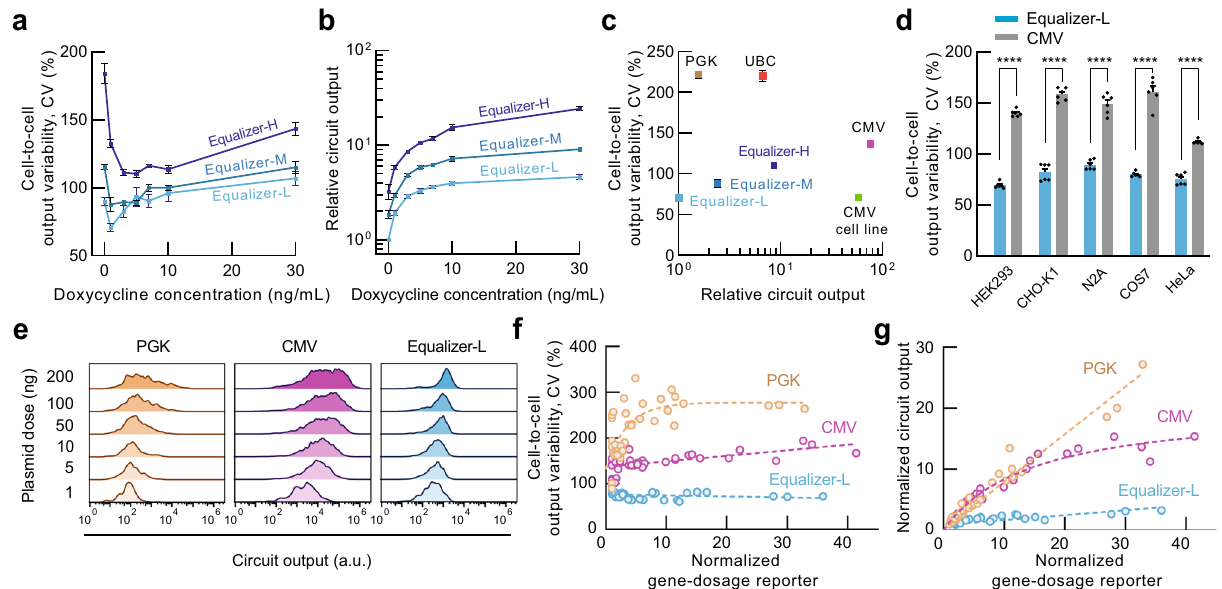
Fig. 3 Equalizers demonstrate robust gene dosage compensation at the single-cell and population levels. Circuit output variability ( a ) and relative mean circuit output levels ( b ) of HEK293 cells transfected with the Equalizer plasmids and cultured under different inducer concentrations. Output levels are relative to that of uninduced Equalizer-L. Mean values ± SEM are shown. n = 8 (Equalizer-L) or 3 (-M/-H) independent transfections. Here and for c , d , 100 ng of circuit plasmids were used per transfection. c Equalizer plasmids produced lower cell-to-cell expression variability than plasmids with unregulated promoters. p < 0.01 for all pairs in Tukey ’ s multiple comparison tests. Cells transfected with Equalizer-L produced similar variability as cells with a chromosomally integrated unregulated CMV cassette (CMV cell line); p > 0.99, Tukey ’ s multiple comparison test. Circuit output values were relative to that of Equalizer-L. Mean± SEM are shown; some error bars are too small to be seen. n = 3 (unregulated circuits and Equalizer-M & -H) or 8 (Equalizer-L) independent transfections. n = 3 independent cell cultures (CMV cell line). Equalizer-L was induced with 1 ng/mL of doxycycline. d Equalizer- L produced lower cell-to-cell variability than the CMV promoter in fi ve cell lines. The black circles are independent transfections. Equalizer-L was induced with 1 ng/mL of doxycycline. Mean ± SEM are shown; some error bars are too small to be seen. n = 6 independent transfections per circuit. **** p < 0.0001; Sidak ’ s multiple comparison test. e Representative output-level histograms. Each histogram was normalized to its peak. For e – g , Equalizer-L was induced with 1 ng/mL of doxycycline. f Equalizer-L produced lower cell-to-cell variability than unregulated promoters at different gene dosage levels. The circles represent independent transfections. n = 36 per circuit (6 per dose and 6 doses per circuit). The dashed lines indicate trend lines (linear for Equalizer-L and CMV; exponential for PGK). The gene-dosage reporter values were normalized to those obtained when transfecting 1 ng of plasmid. g The mean Equalizer- L output is robust to increases in gene dosage. The gene-dosage and circuit output values were normalized to those obtained when transfecting 1 ng of plasmid. The circles and sample sizes are as in ( f ). The dashed lines indicate trend lines (linear for Equalizer-L and PGK, hyperbolic for CMV). Source data are provided as a Source Data fi